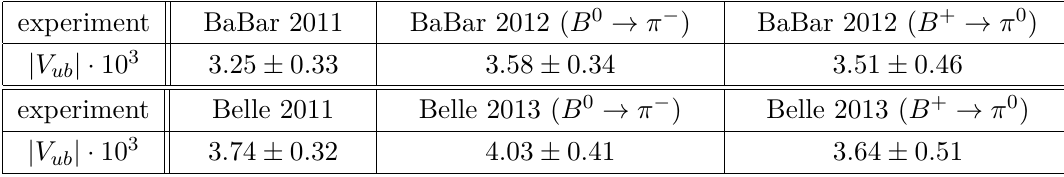
Table 3 . The correlated weighted averages (3.13) for each of the six experiments of refs. [35–38]. The theoretical DM bands of the FFs correspond to the use of the combined LQCD data of table 1 as